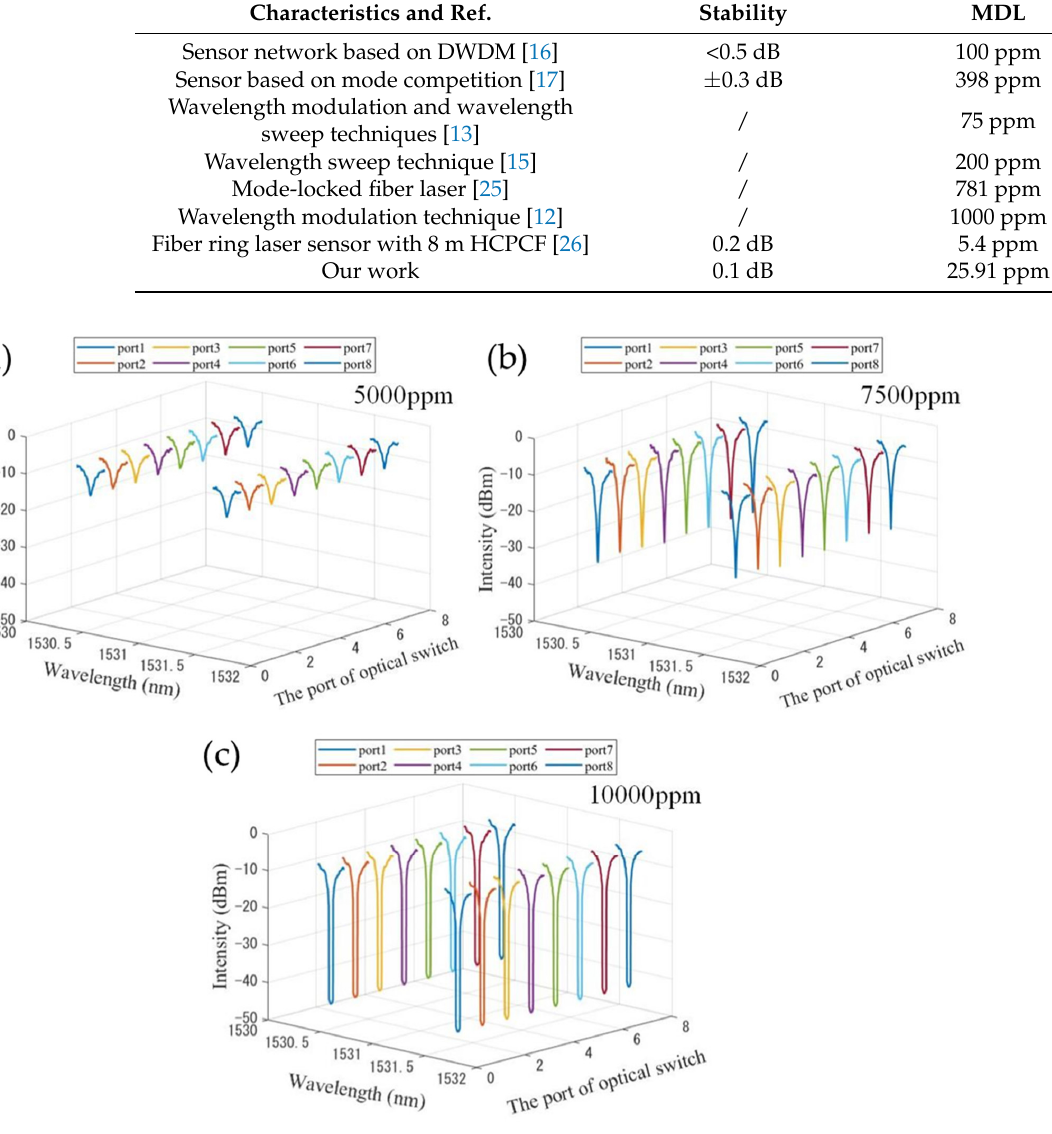
Table 1. The performance comparison of other similar works.